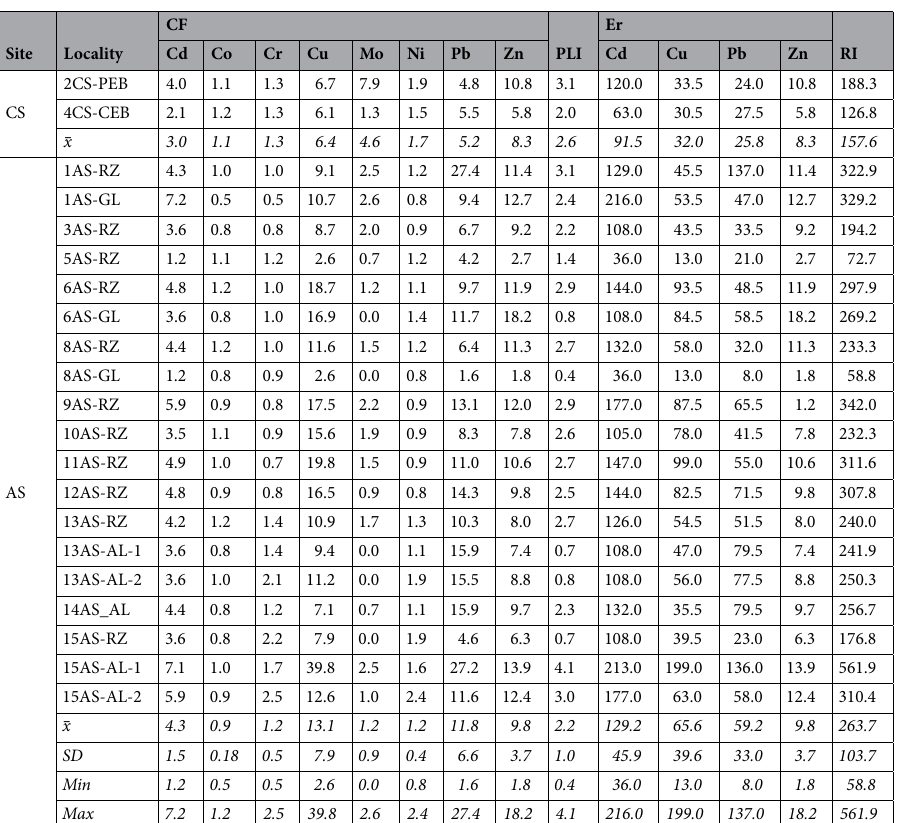
Table 4. Contamination factor (CF), pollution load index (PLI), potential ecological risk factor (Er), potential ecological risk of the environment (RI) for contaminated and alluvial sites in the soil depth of 0–10 cm. AS alluvial site, CS contaminated site, RZ riparian zone, AL arable land, GL grassland, PEB probable environmental burden, CEB confirmed environmental burden. The CF < 1 means low contamination, 1–3 is moderate contamination, 3–6 is considerable contamination and CF > 6 means very high contamination. The PLI > 1 indicates pollution. The Er < 40 means low risk, 40–80 is moderate risk, 80–160 is considerable risk, 160–320 is high risk, and > 320 is very high risk. The RI < 150 means low risk, 150–300 is moderate risk, 300–600 is considerable risk, and > 600 is very high